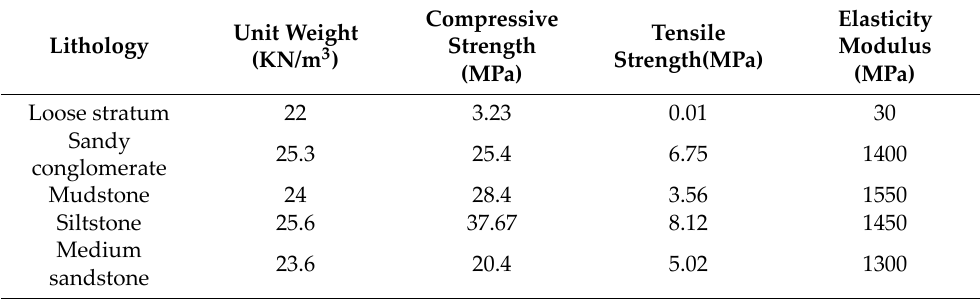
Table 2. Physical and mechanical parameters of strata in Tashidian Erjingtian